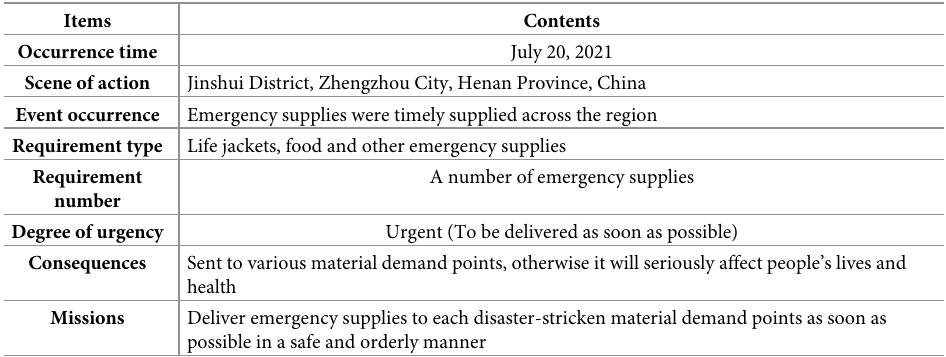
Table 4. Summary table of epidemic scenarios.